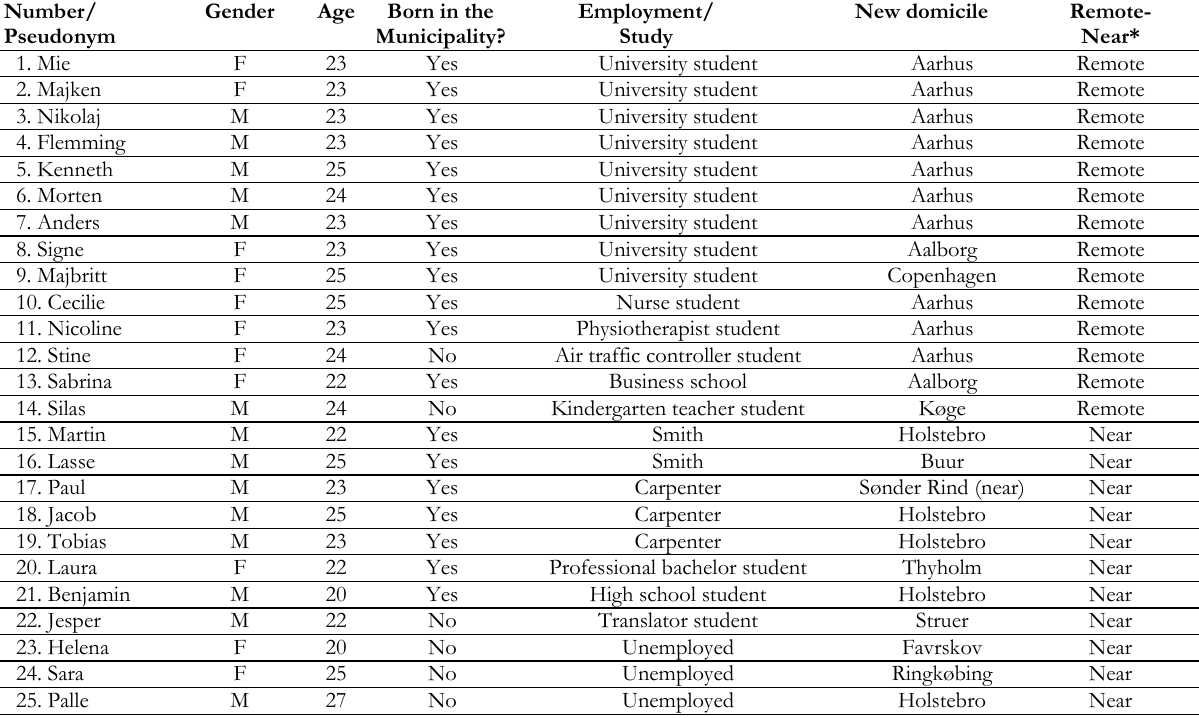
Table 1. Telephone interviews with young outmigrants from Lemvig Municipality, Denmark, November 2012. List of interview